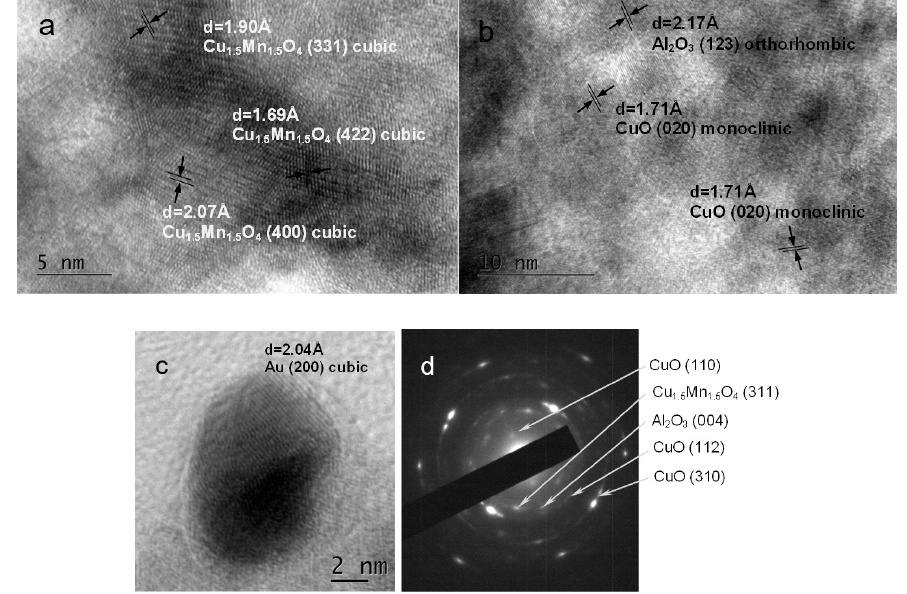
Figure 3. The High-resolution transmission electron microscopy (HRTEM) micrograph of a fresh Au/CuMn (2:1) catalyst at a magnification of 600 k ( a , b ) and the corresponding Selected area electron diffraction (SAED) patterns ( d ). The presence of the gold particle is also shown in ( c ) (magnification 800,000×).